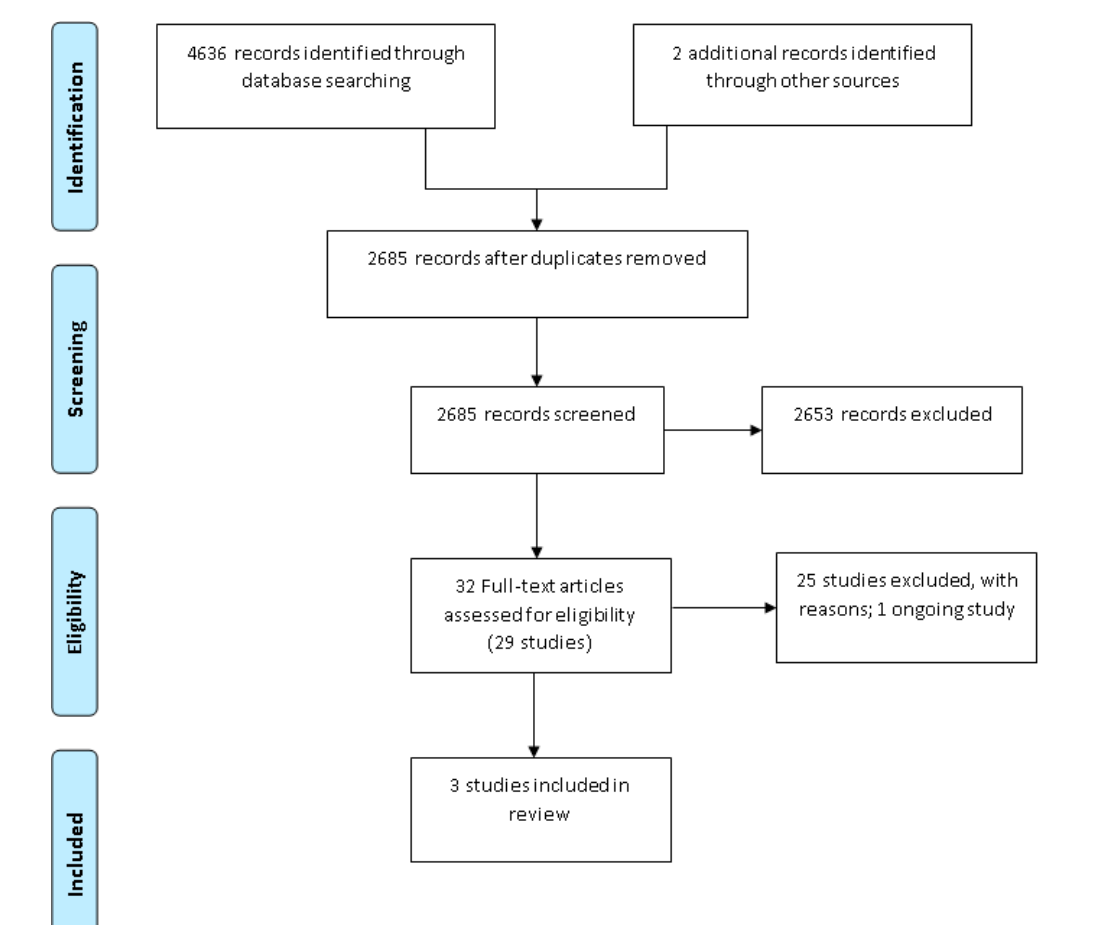
Figure 1. Preferred Reporting Items for Systematic Reviews and Meta-Analysis (PRISMA) diagram.